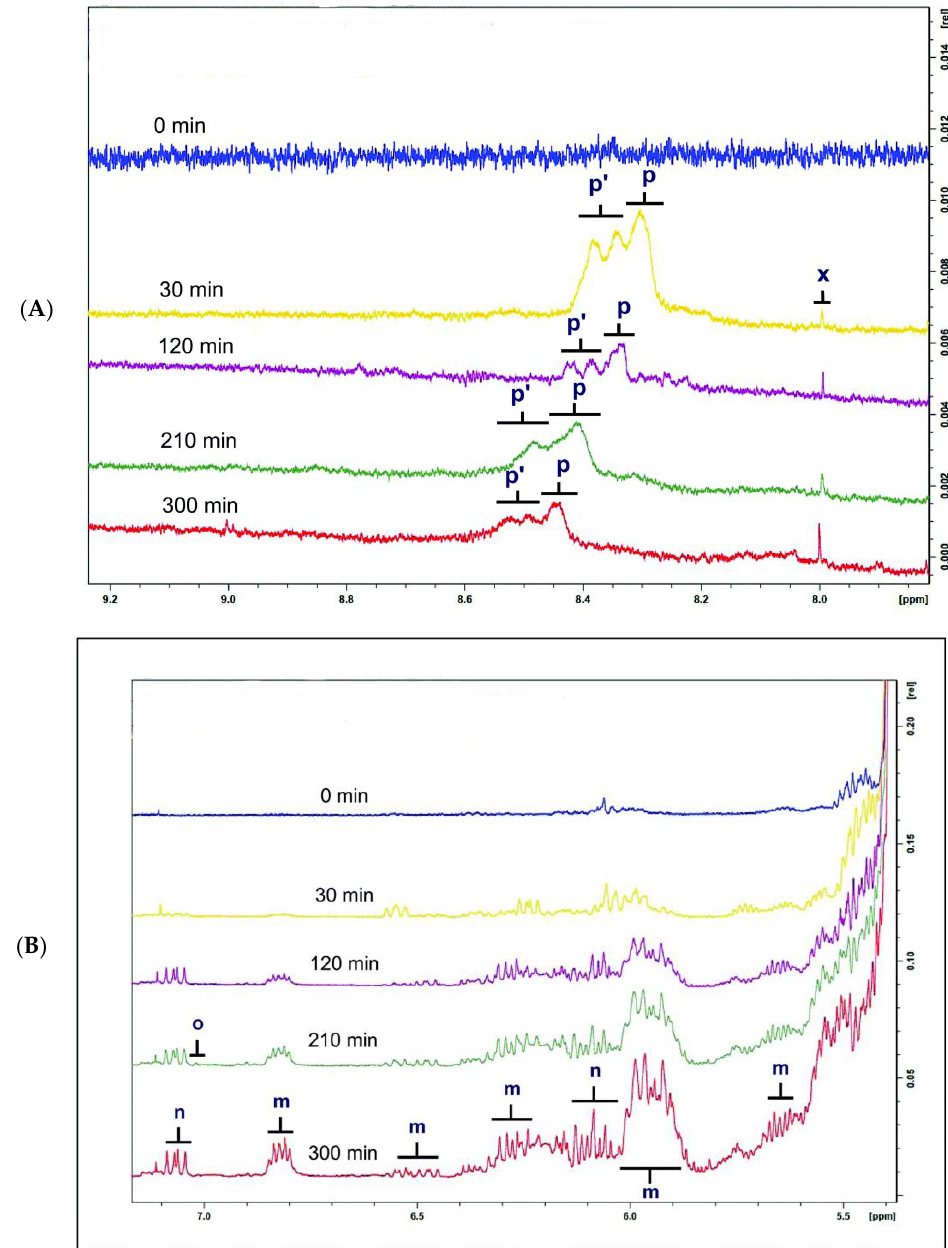
Figure 27. 1 H-NMR spectra (600 MHz) of ( A ) hydroperoxide group (primary LOPs) and methanoic acid present in the 7.5 – 9.2 ppm region. Signal p denotes the OOH – ( E , E ) hydroperoxide function, p ′ the OOH – ( Z , E ) hydroperoxide function; and ( B ) of conjugated diene hydroperoxyl dienes and hydroxy monoenes (primary LOPs), and olefinic resonances of α , β -unsaturated aldehydes present in the 5.4–7.1 ppm regions of sunflower oil, thermally stressed continuously throughout a 300 min period. For m and n there is overlap, due to the presence of several unsaturated chain lengths; x denotes methanoic acid. Adopted with permission from [126]. Copyright 2019, Royal Society of Chemistry.